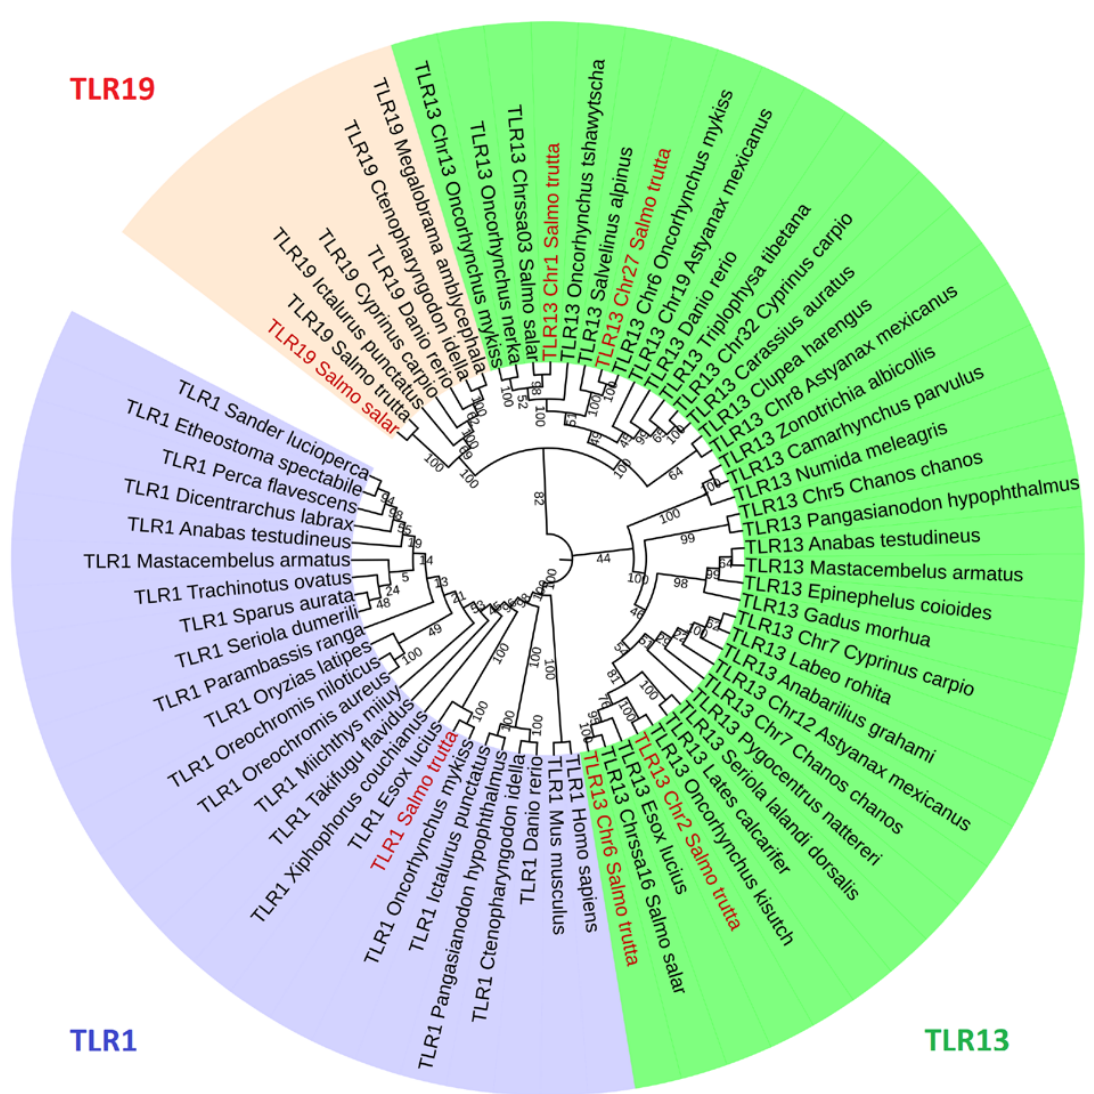
Figure 5. Phylogenetic tree of TLRs from different vertebrates. The tree was generated using MEGA X using the maximum likelihood method. The different gene groups are denoted by various colors, TLR1—blue; TLR19—red; TLR13-like—dark green. The leaves with red legend indicate brown trout TLRs. The GenBank accession numbers of the sequences are available in Supplementary Table S2.